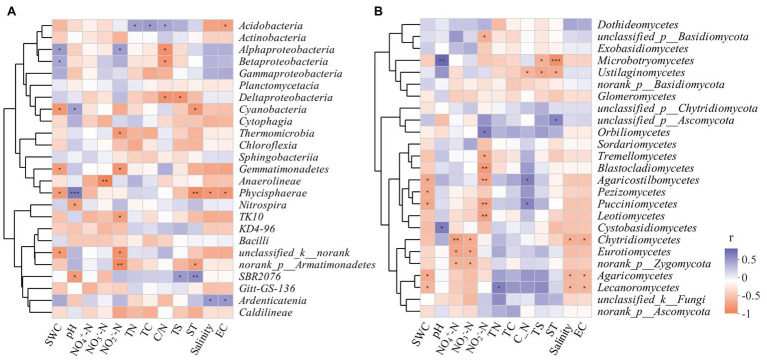
Spearman correlation heatmap of the top 25 soil bacterial (A), fungal (B) classes and soil properties. X and Y axis are environmental factors and classes. R in different colors to show, the right side of the legend is the color range of different r values. *
p < 0.05; **
p < 0.01; ***
p < 0.001.